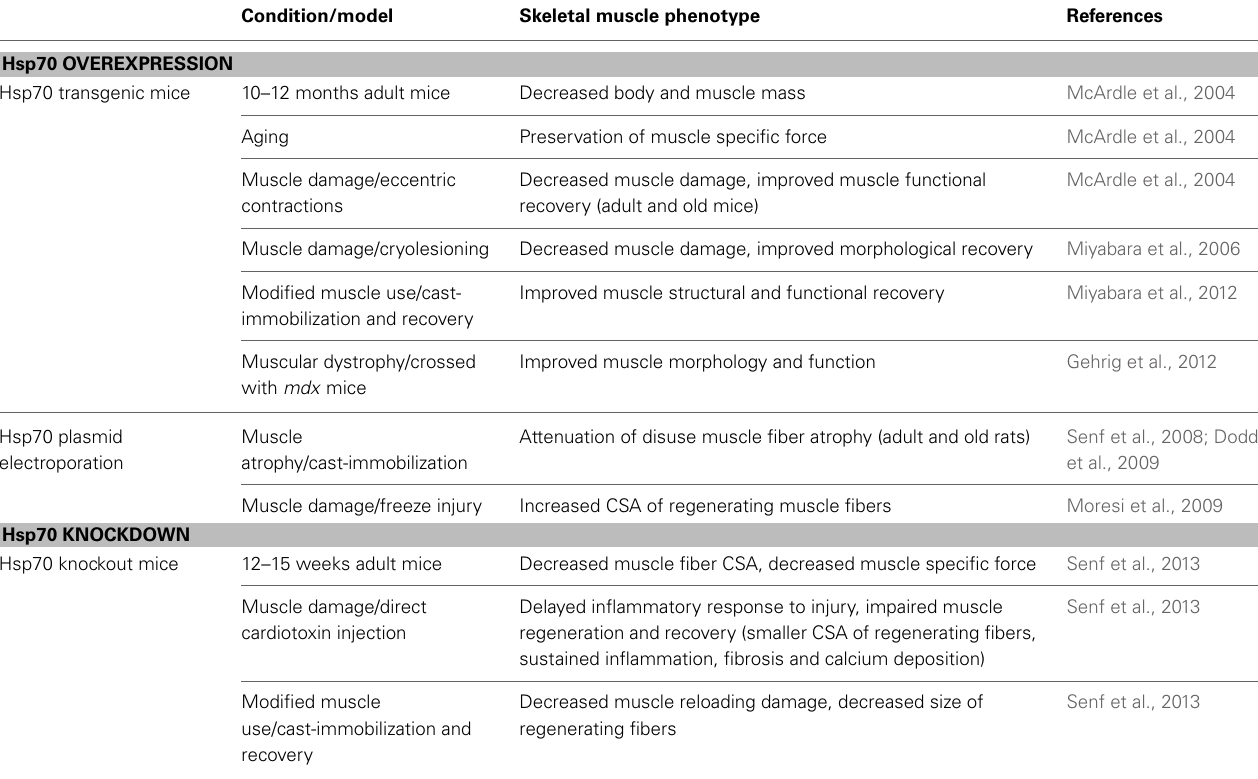
Table 1 | List of studies which have directly manipulated Hsp70 expression to investigate the functions of Hsp70 in regulating skeletal muscle